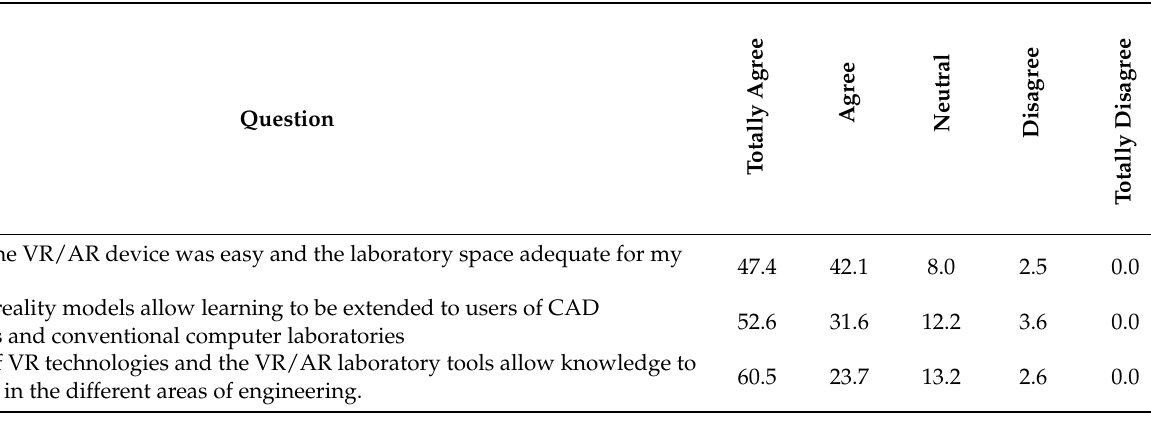
Table 2. User satisfaction results for engineering students regarding the VR/AR laboratory at